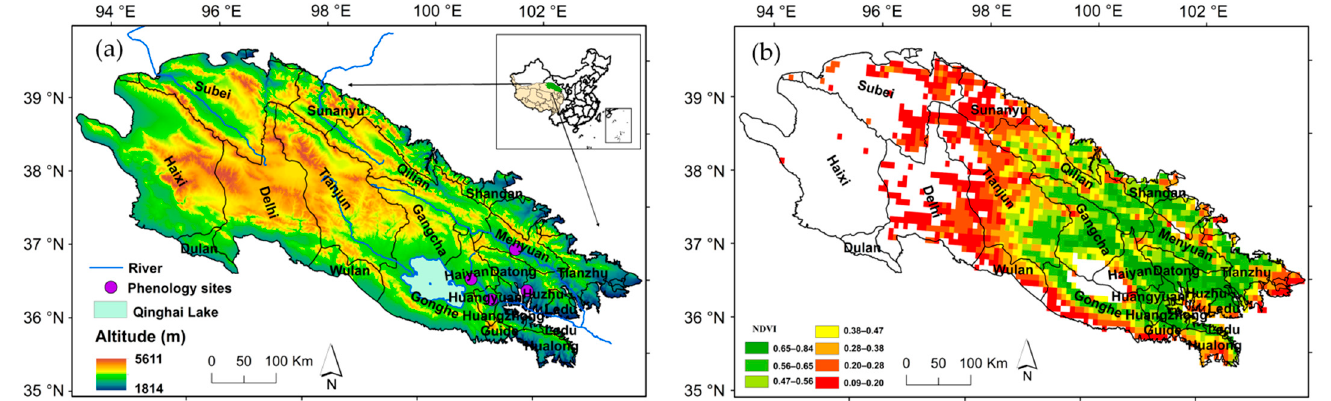
Figure 1. Basic geographic information of the Qilian Mountains and the region available for research in this study. ( a ) Location and altitude of the Qilian Mountains; ( b ) the study area is exemplified by the spatial scope of the Normalized Difference Vegetation Index (NDVI) on one arbitrary day (15 July 1982).